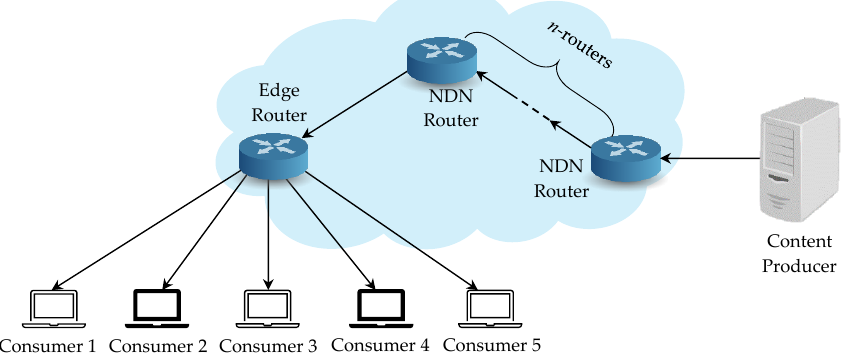
Figure 11. Network topology for performance